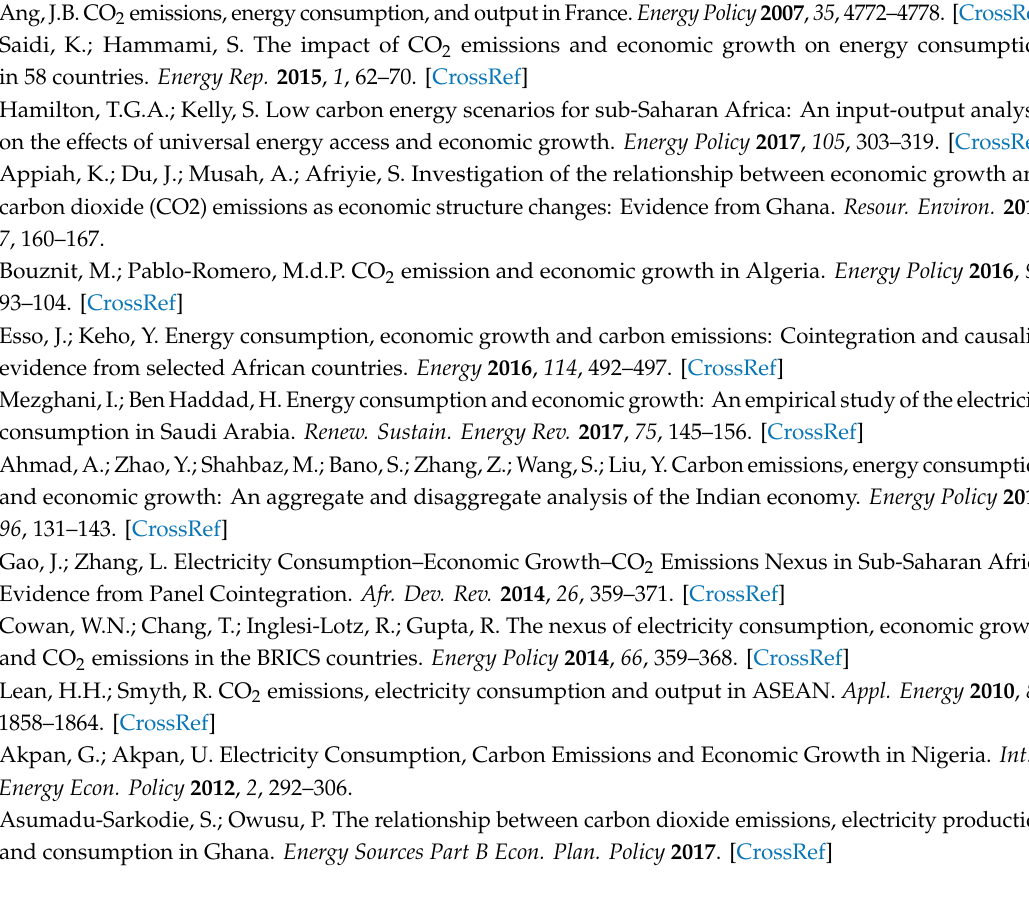
Figure A10. Cumulative effect of GDP on CO.